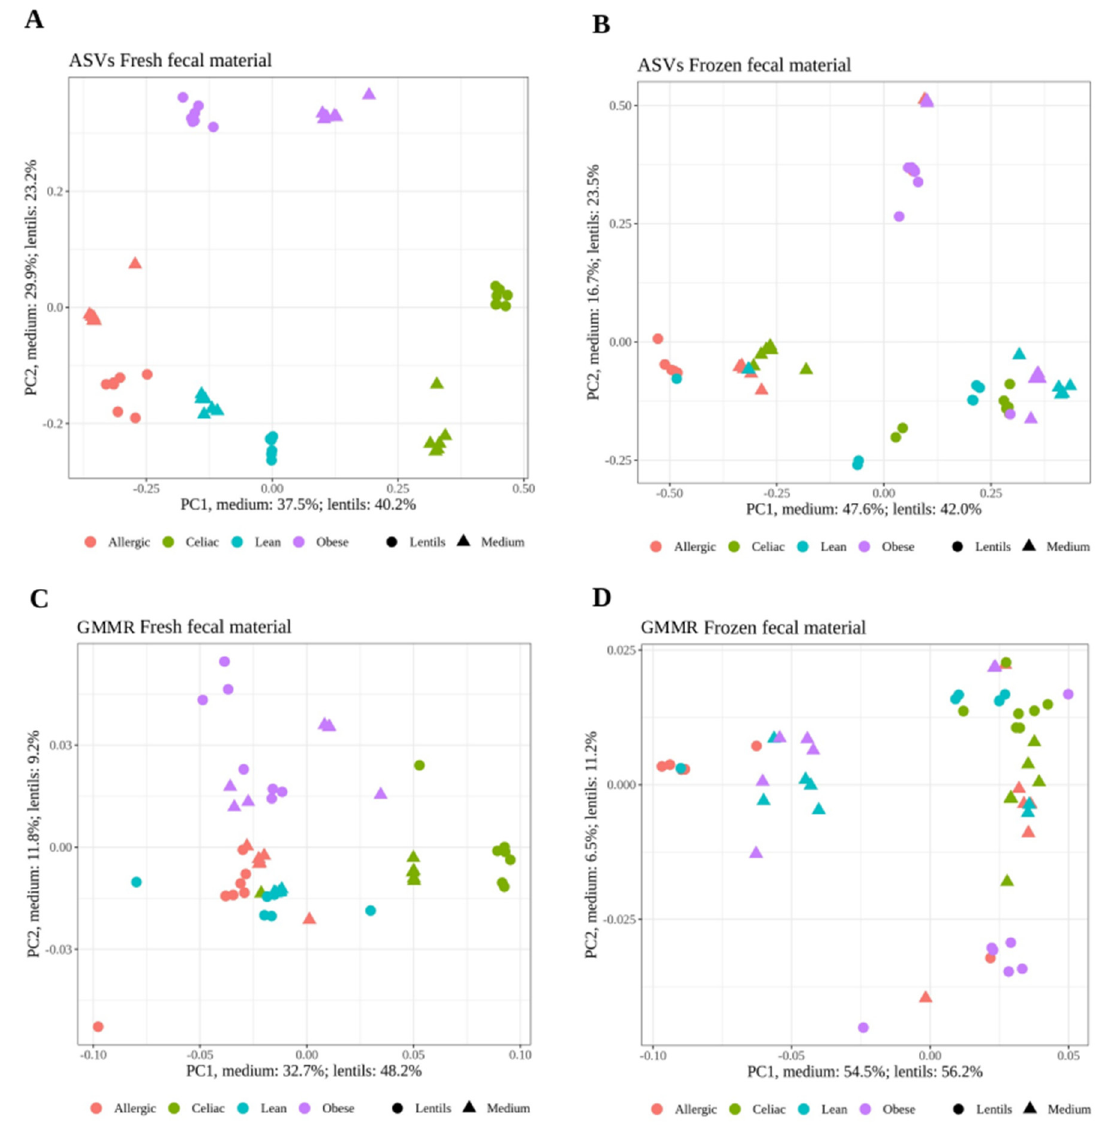
Figure 2. Principal coordinates analysis (PCoA) with Bray–Curtis dissimilarity of the gut microbial community structure (ASVs) for fresh fecal material ( A ) and frozen fecal material ( B ) and with Jaccard dissimilarity for active reactions after contextualizing a gut microbiota metabolic network (GMMR) of fresh fecal material ( C ) and frozen fecal material ( D ) after stabilization and after in vitro fermentation of lentils. Dots and triangles in the same color represent the samples from six different days.